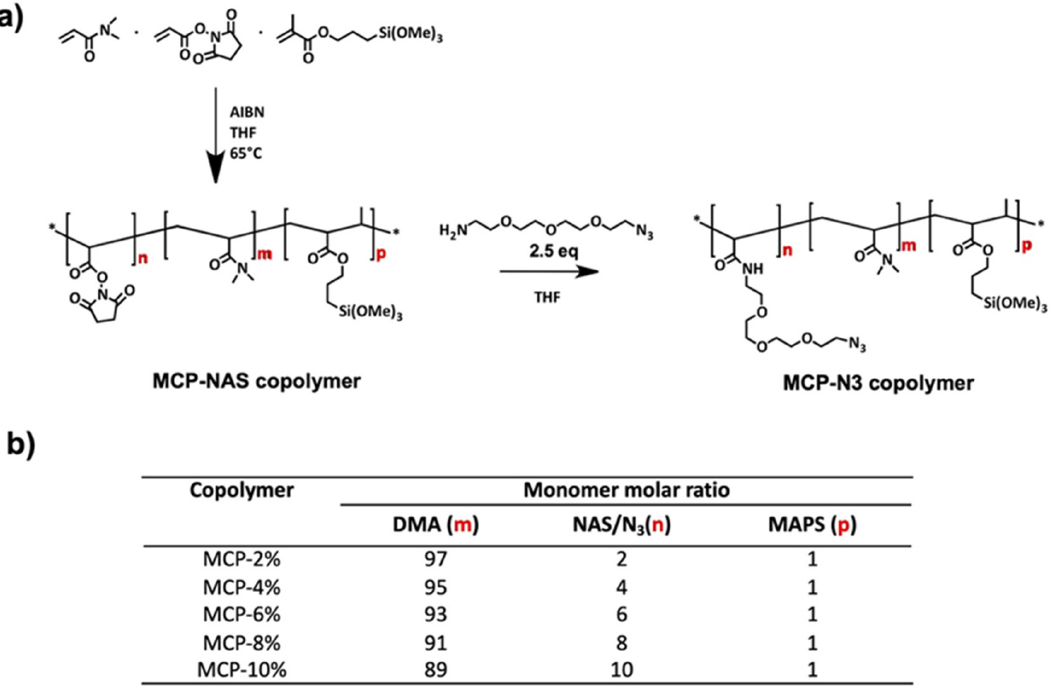
Figure 1. ( a ) Synthesis of MCP-NAS polymers and post-polymerization modification of NAS monomers with 2.5 equivalents of 11-Azido-3,6,9-trioxaundecan-1-amine to obtain the MCP-N derivatives; ( b ) composition of MCP 3